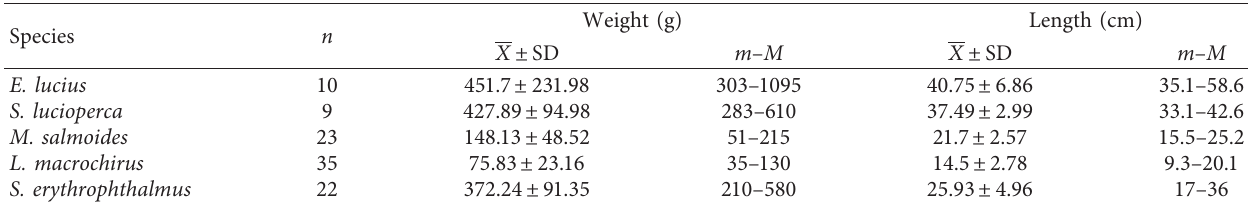
Table 3: Number of fish species and weight and length of the studied fish species.